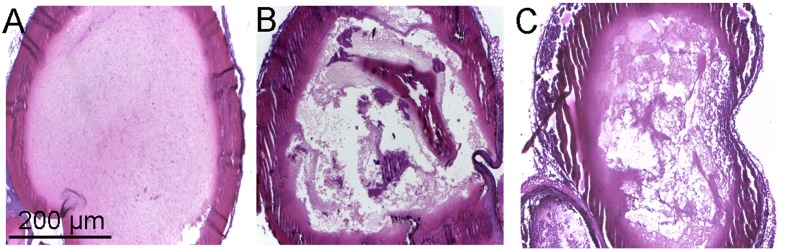
Effect of toddalolactone on arterial thrombosis induced by FeCl3. (A) Sham group; (B) FeCl3-induced mice not given toddalolactone; (C) toddaloctone-treated mice.